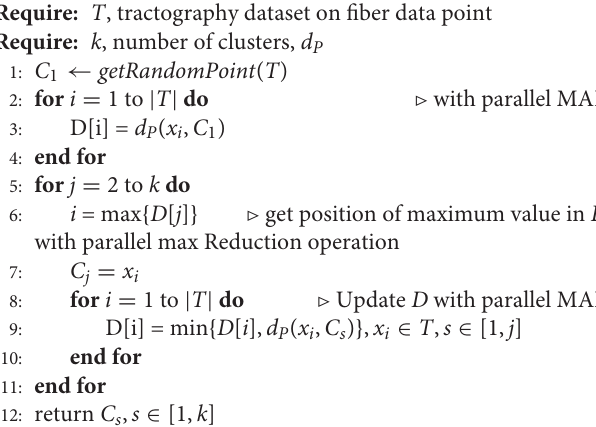
Algorithm 1: Kmeans++